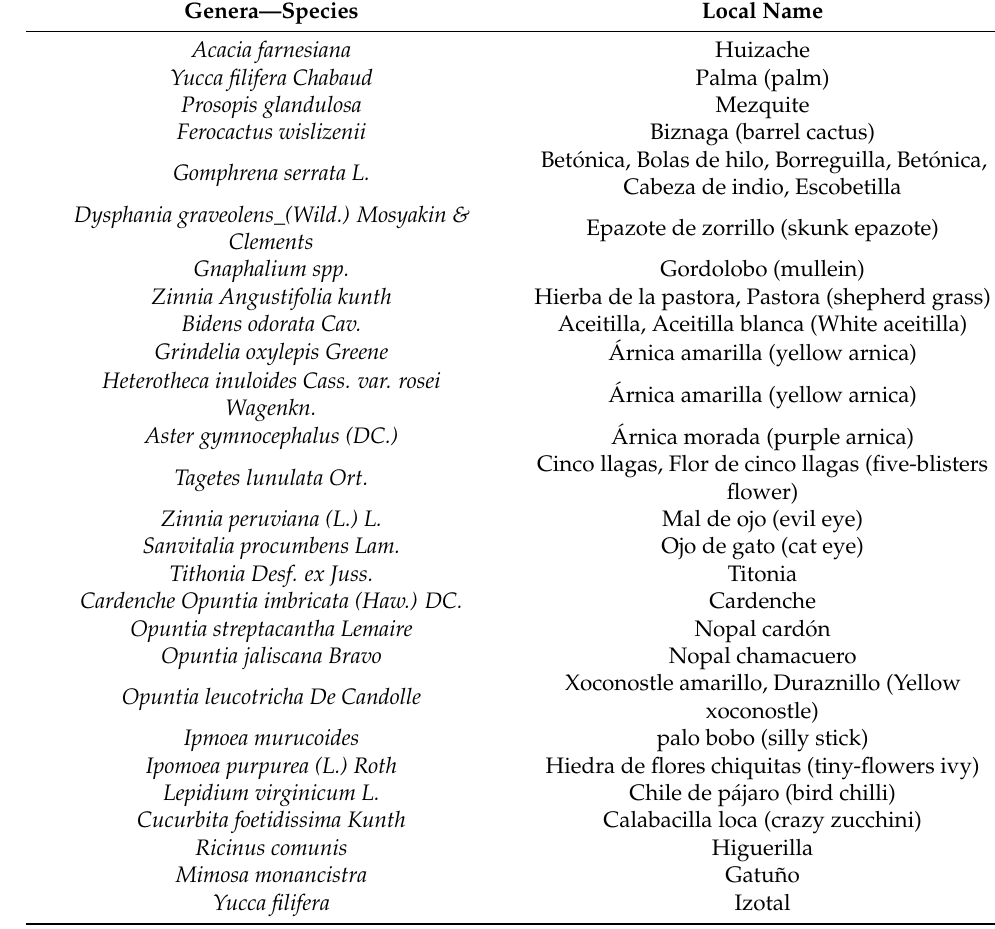
Table 4. Typification of flora in the study zone.